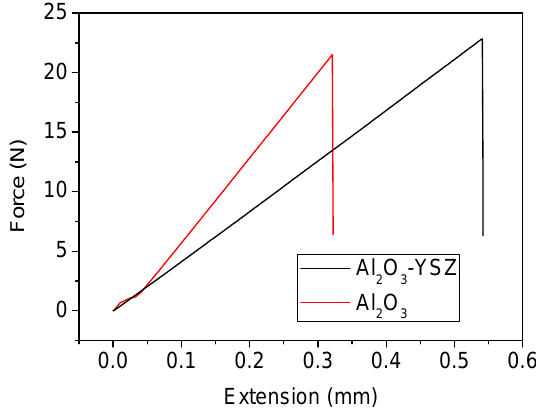
Figure 4. Extension ‐ force bending curves of the Al 2 O 3 ‐ YSZ and pure alumina seven ‐ channel capillary Figure 4. Extension-force bending curves of the Al 2 O 3 -YSZ and pure alumina seven-channel membranes. capillary